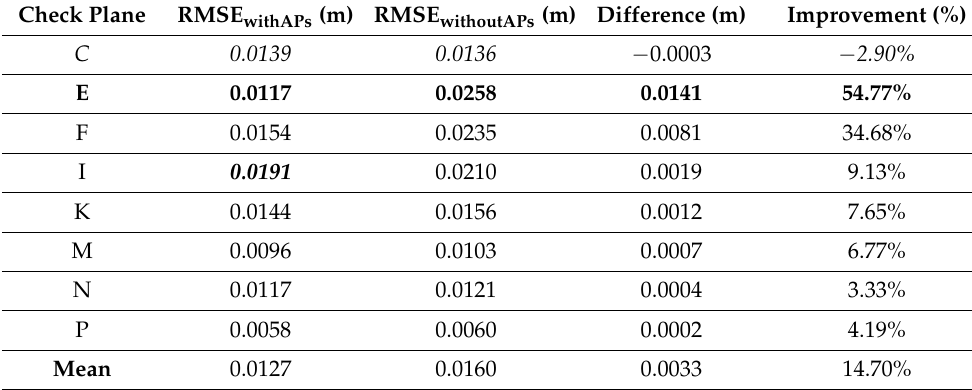
Table 13. RMSE of each check plane for dataset DATA3. Check